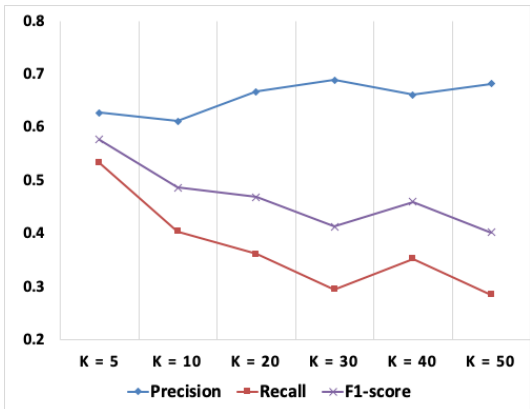
Figure 12. Results of using the k-nearest neighbors (KNN) classification model for traceability recovery with different k values on the eANCI dataset.